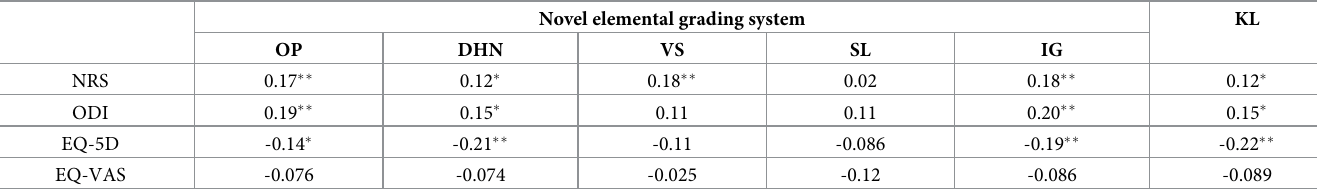
Table 5. Correlation between radiographic features of lumbar spondylosis and NRS or health-related QOL. Novel elemental grading system KL OP DHN VS SL